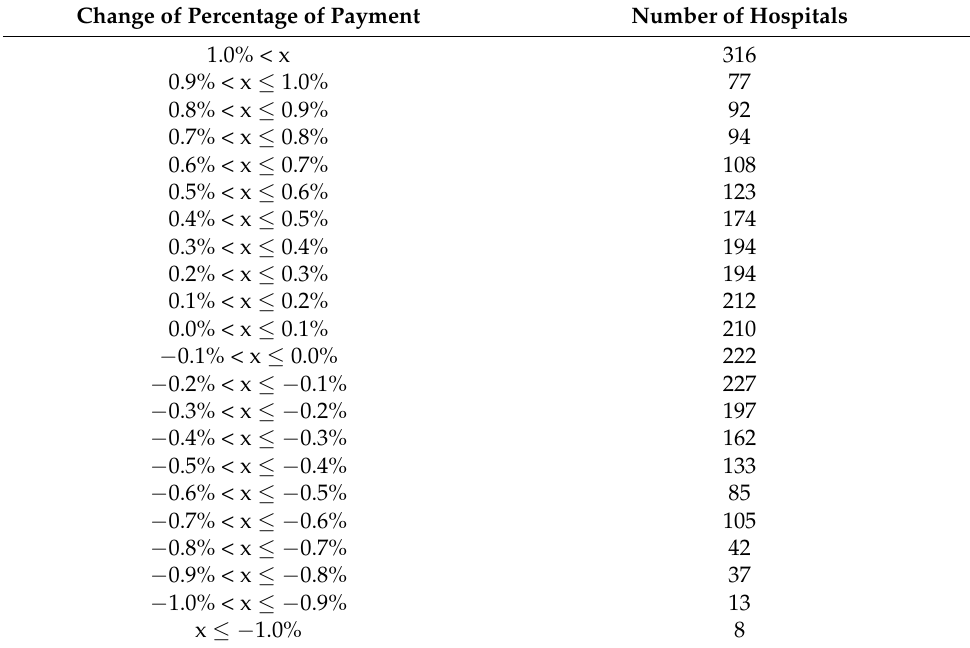
Table 3. Distribution of percentage change of payments for FY 2016.